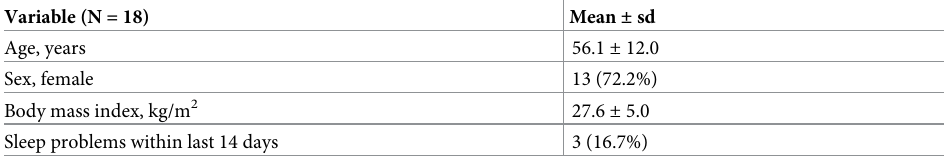
Table 1. Demographic characteristics of participants.